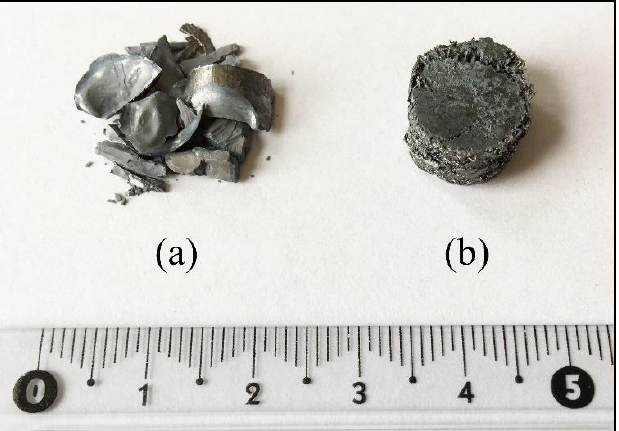
Figure 9. Appearance of ( a ) TiO 2 , ( b ) composite structure with TiO 2 –Ti6Al4V hybrid after compressive testing (sample diameter was 10 mm and unit cell size was 1 mm).